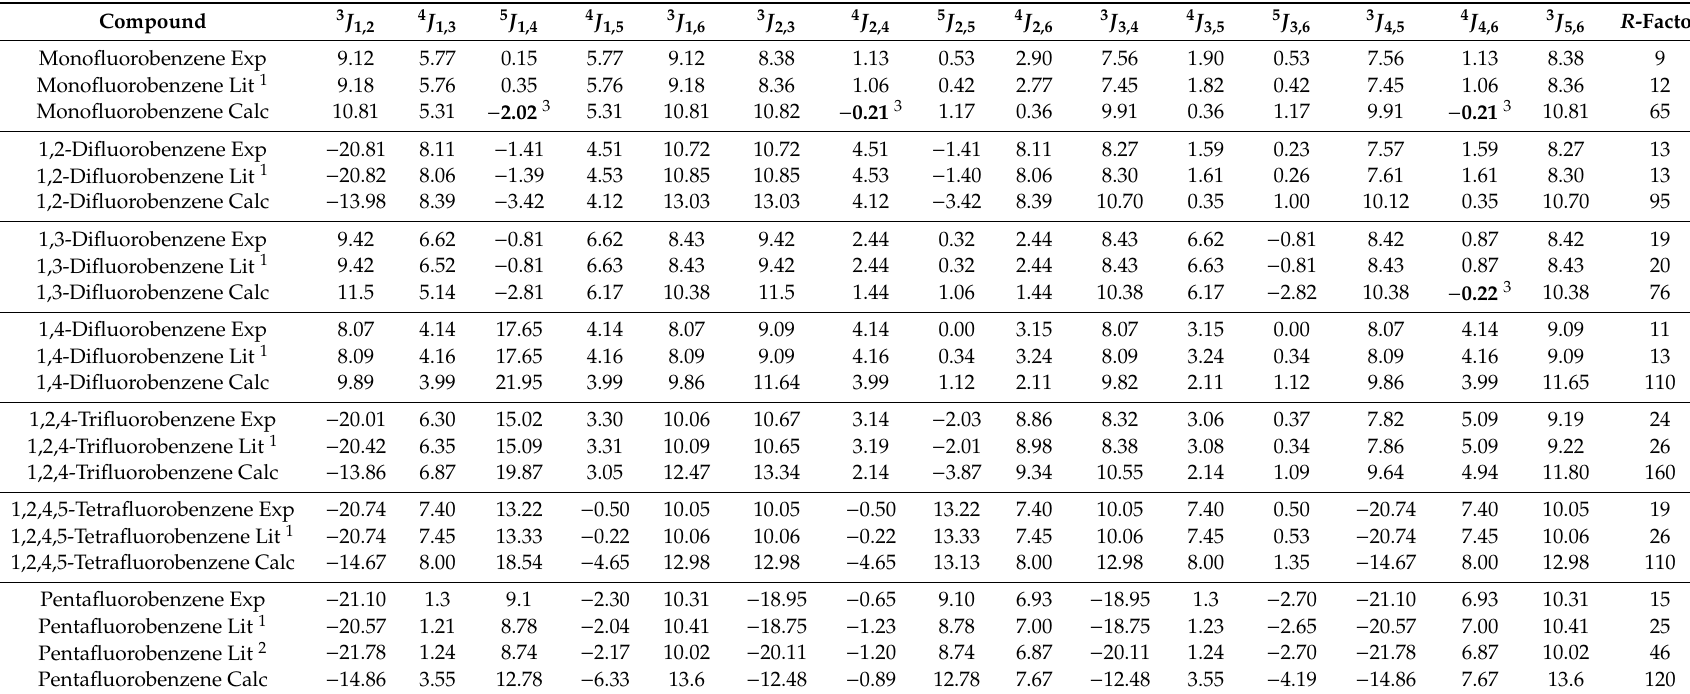
Table 2. J -couplings obtained from the JCS simulations (Exp) and compared with literature (Lit) values and ab initio calculations (Calc). The R -factor for each set of J -couplings is also